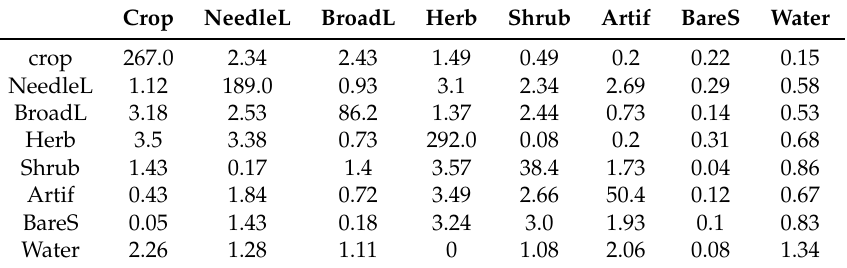
Table A3. Confusion matrix with random errors and large overall accuracy.